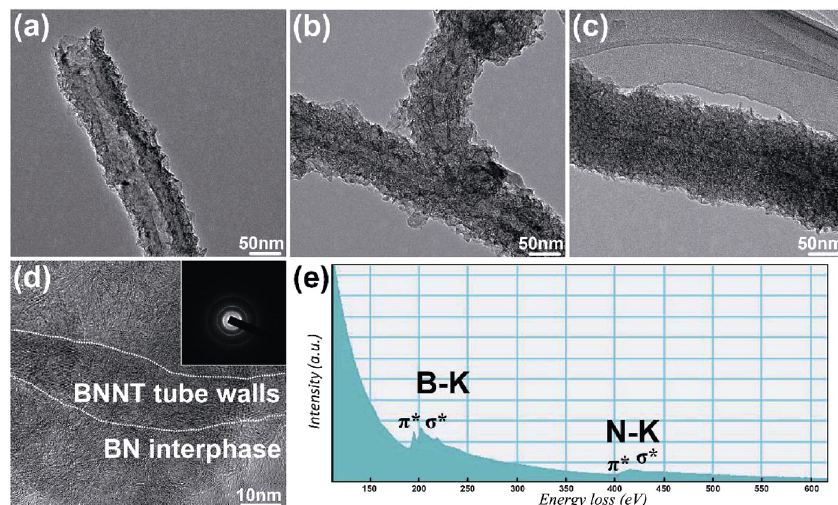
Fig. 2 Representative TEM images of BN-coated BNNTs with deposition time of (a) 10 min, (b) 20 min, and (c) 40 min. The thickness of BN interphase increases as the deposition time prolongs. (d) High-resolution TEM image of BN interphase deposited on the nanotube surface. The inset shows selected area electron diffraction (SADE) pattern of the interphase. (e) EELS spectrum taken from the